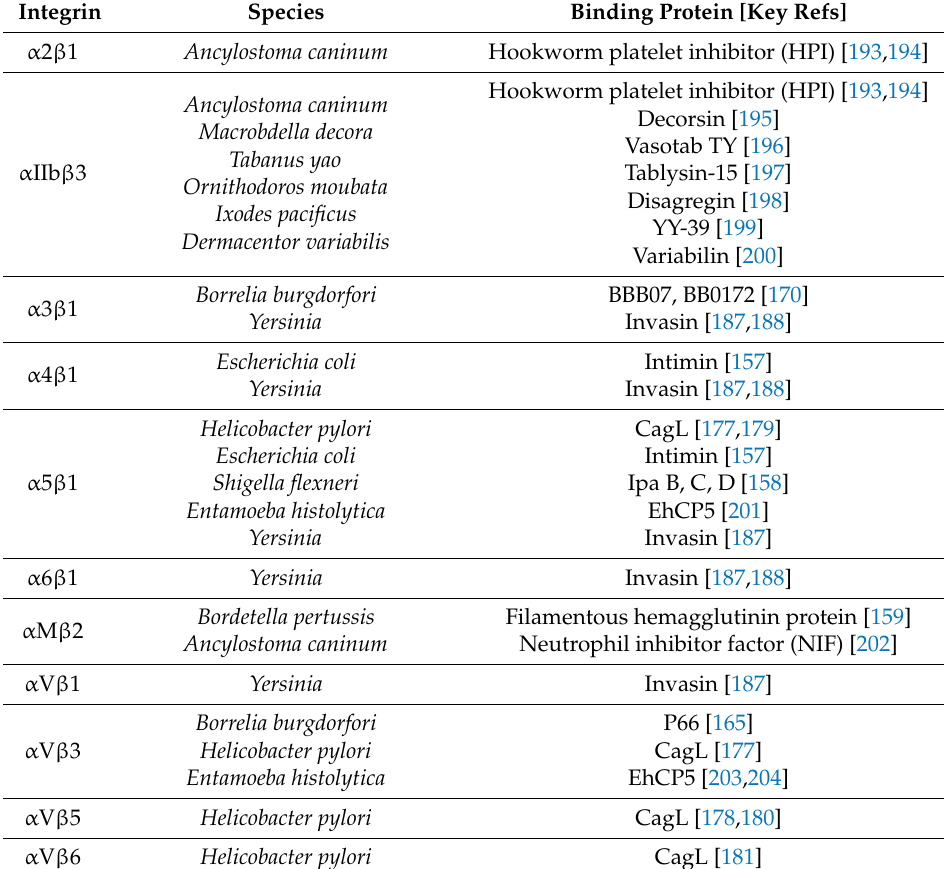
Table 4. Integrin binding by bacteria and parasitic